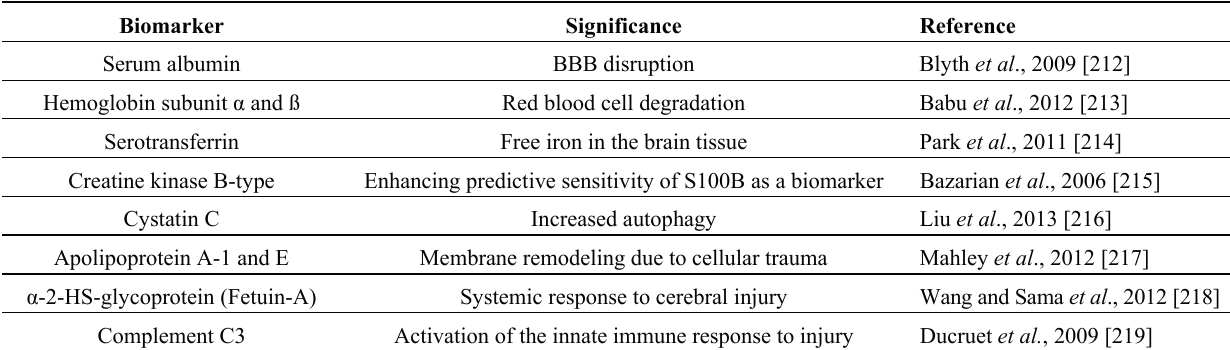
Table 6. Potenial microdialysis